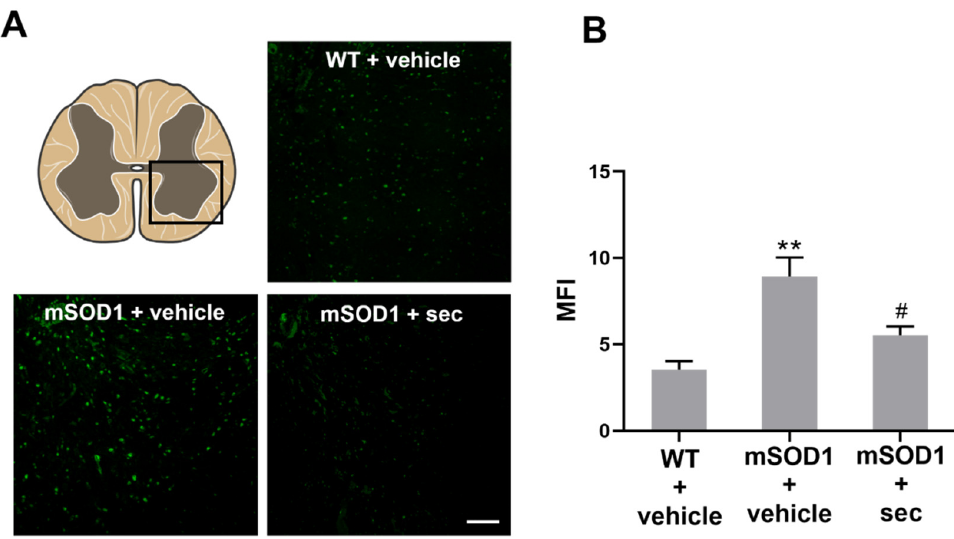
Figure 6. Intrathecal injection of the secretome from anti-miR-124-modulated mSOD1 motor neurons (MNs) in the lumbar spinal cord of mSOD1 mice at 12 weeks of age prevents age-associated neurodegeneration after 3 weeks of its administration. ( A ) Representative images of the ventral horn of the lumbar section grey matter stained by Fluoro-Jade B fluorescence (square) from 15-week-old wild-type (WT)/SOD1-G93A (mSOD1) mice injected with the vehicle (basal media of NSC-34 MNs) and mSOD1 mice injected with the secretome derived from mSOD1 MNs modulated with anti-miR-124 (mSOD1 + sec); ( B ) the respective quantification of mean fluorescence. Scale bar: 100 µ m. Data from 3 animals per group are expressed as fold change (mean ± SEM) vs. WT + vehicle. ** p < 0.01 vs. WT + vehicle; # p < 0.05 vs. mSOD1 + vehicle, one-way ANOVA followed by multiple-comparisons Bonferroni post hoc correction. MFI, mean fluorescence